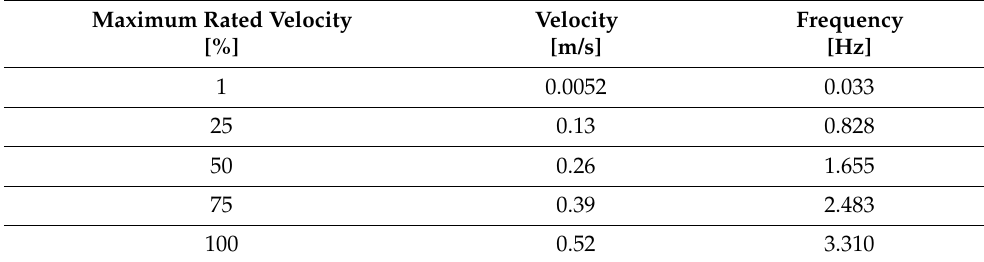
Table 1. The frequency values vs. maximum rated